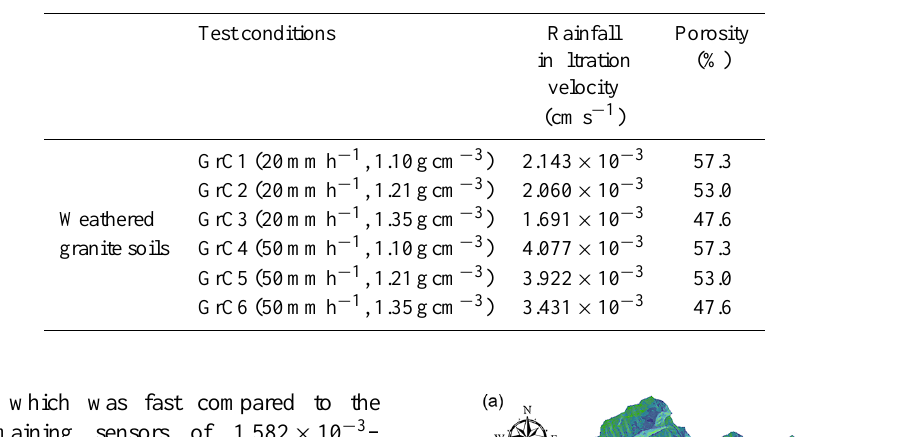
Table 4. Rainfall infiltration velocity in each test conditions.